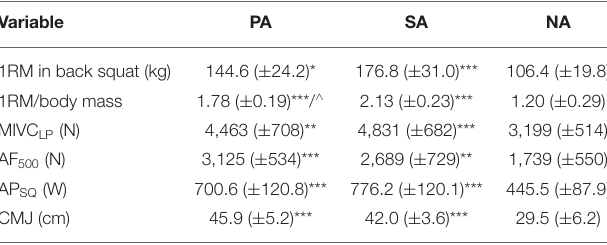
TABLE 1 | Group mean values ( ± SD) of 1RM in back-squat, 1-RM relative to body mass, and all test procedures measured during the Pre-measurements.